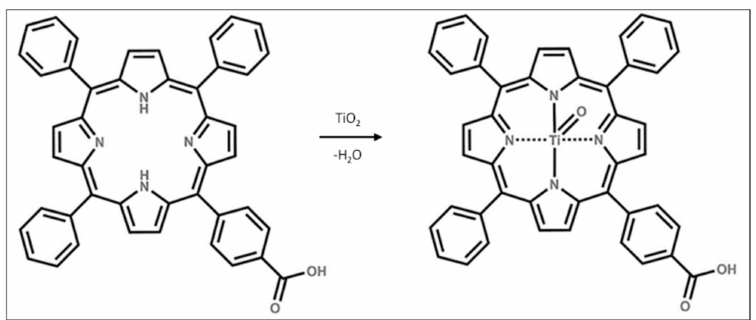
Figure 3. MCTPP (5-monocarboxyphenyl-10,15,20-triphenylporphyrin) and its possible self-metalation product after adsorption on rutile TiO 2 (110) surface. Adapted and reprinted with permission from [33], Copyright (2018) American Chemical Society